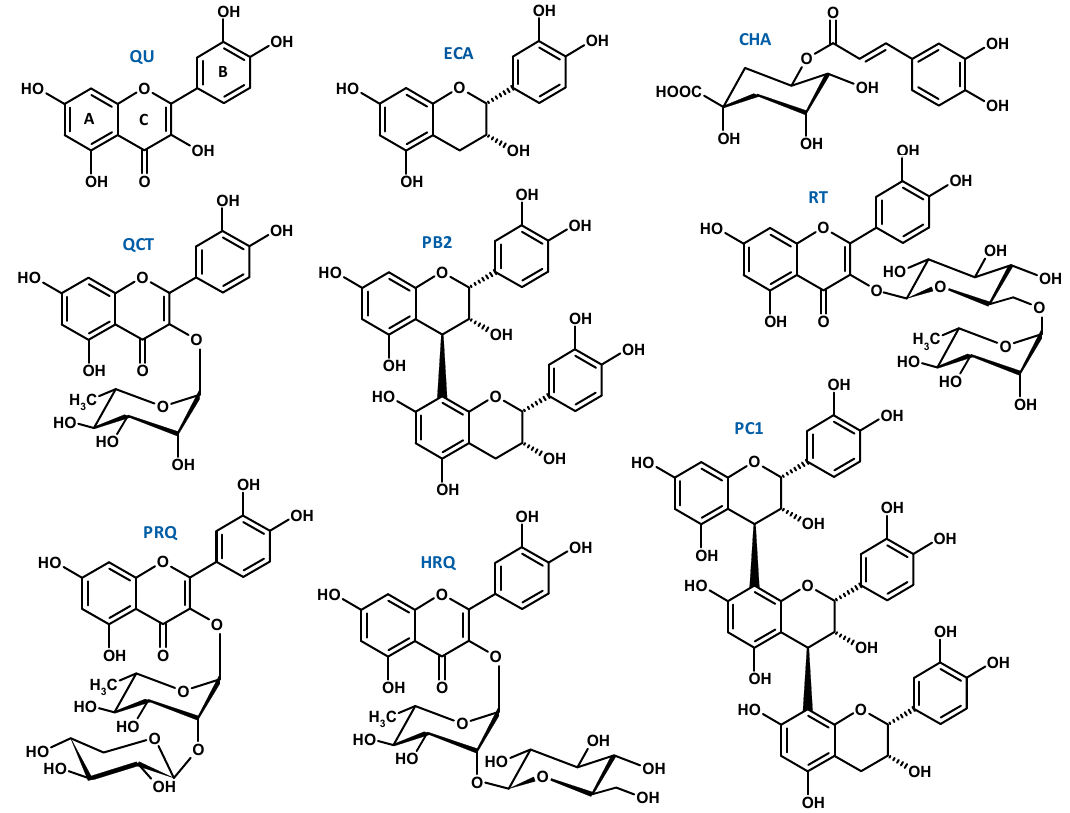
Figure 1. Structures of the activity markers of S. domestica leaves: ECA, (–)-epicatechin; CHA, chlorogenic acid (5- O -caffeoylquinic acid); PB2, procyanidin B2; PC1, procyanidin C1; QU, quercetin; QCT, quercitrin (quercetin 3- O - α - L -rhamnopyranoside); RT, rutin; HRQ, quercetin 3- O -(2’’- O - β - D - glucopyranosyl)- α - L -rhamnopyranoside (HRQ); PRQ, quercetin 3- O -(2’’- O - β - D -xylopyranosyl)- α - L - rhamnopyranoside; the capital letters A-C on the QU formula refer to the common nomenclature of the basic flavan skeleton.